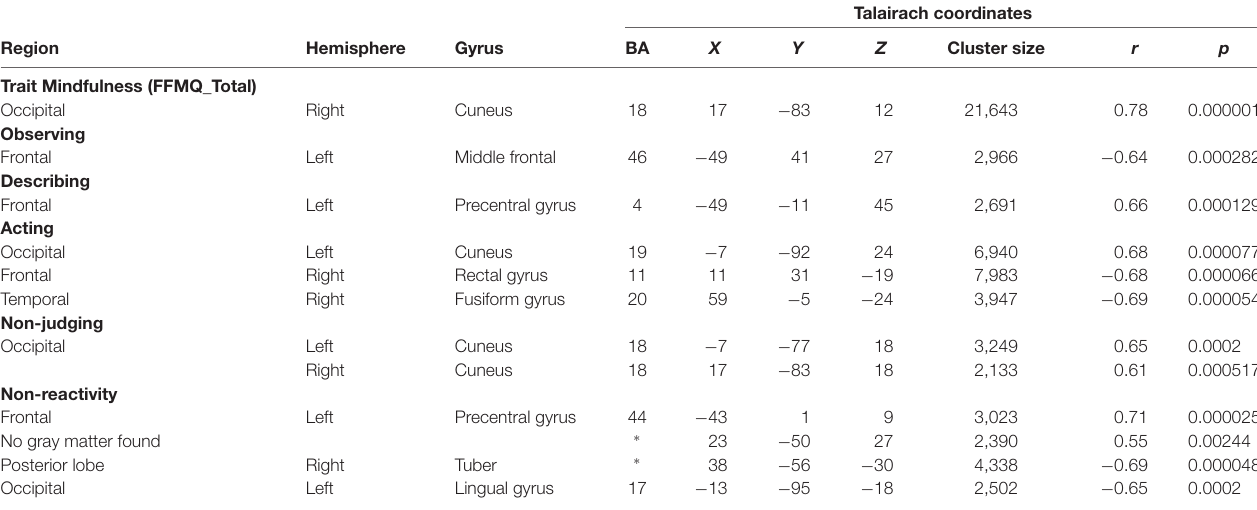
TABLE 3 | Talairach coordinates of correlations between FFMQ scores and functional connectivity with the salience network (SN).